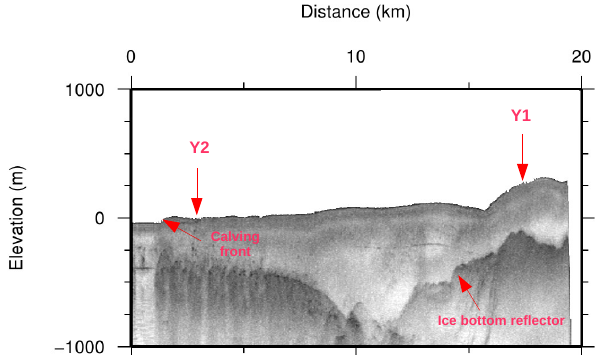
Figure 7. Airborne radar profile corresponding to the Y1–Y2 profile of Fig.